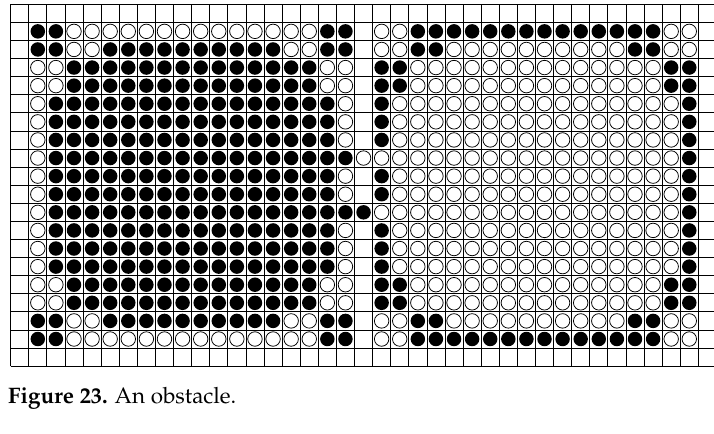
Figure 23. An obstacle.